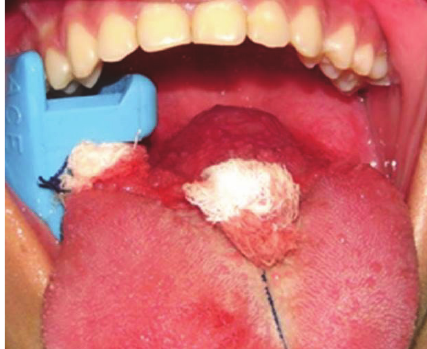
Figure 3: Nodular lesion at the base of the tongue after incision and detachment of the lingual mucosa.